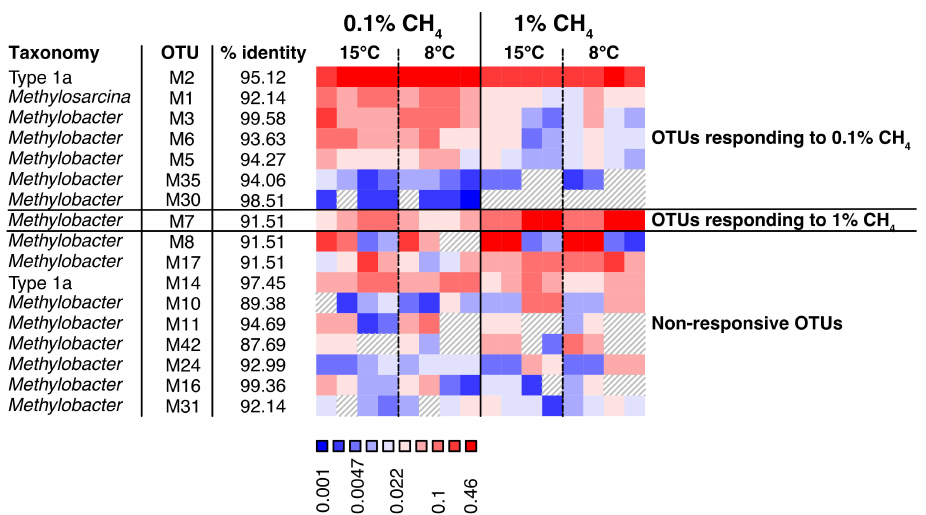
Figure 7. Relative abundances of pmoA transcripts representing MOB OTUs (A189F/mb661R primer pair) from grazed peat soil microcosms after incubation at 0.1% and 1% CH 4 concentrations. OTUs with higher relative abundance at 0.1% CH 4 are shown in the first block (left), and those with higher relative abundance at 1% CH 4 in the second block (right). The non-responsive OTUs with the highest relative abundance are shown in the third block. The number of OTUs included in the figure make up 90% of the total MOB community transcription. OTUs are identified by the letter M (indicating that these are part of the mb661R dataset) and a number. The percentage of identity between the OTU and the best hit in the database is given next to the OTU identification. The highest possible taxonomic rank identified was chosen for each OTU. Relative abundances reach from low abundances (blue) to high (red).